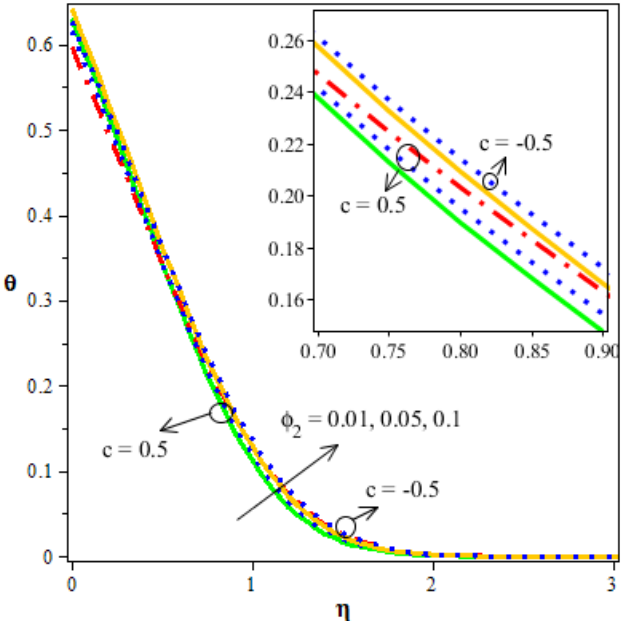
Figure 9. The curve θ ( η ) on φ 2 .